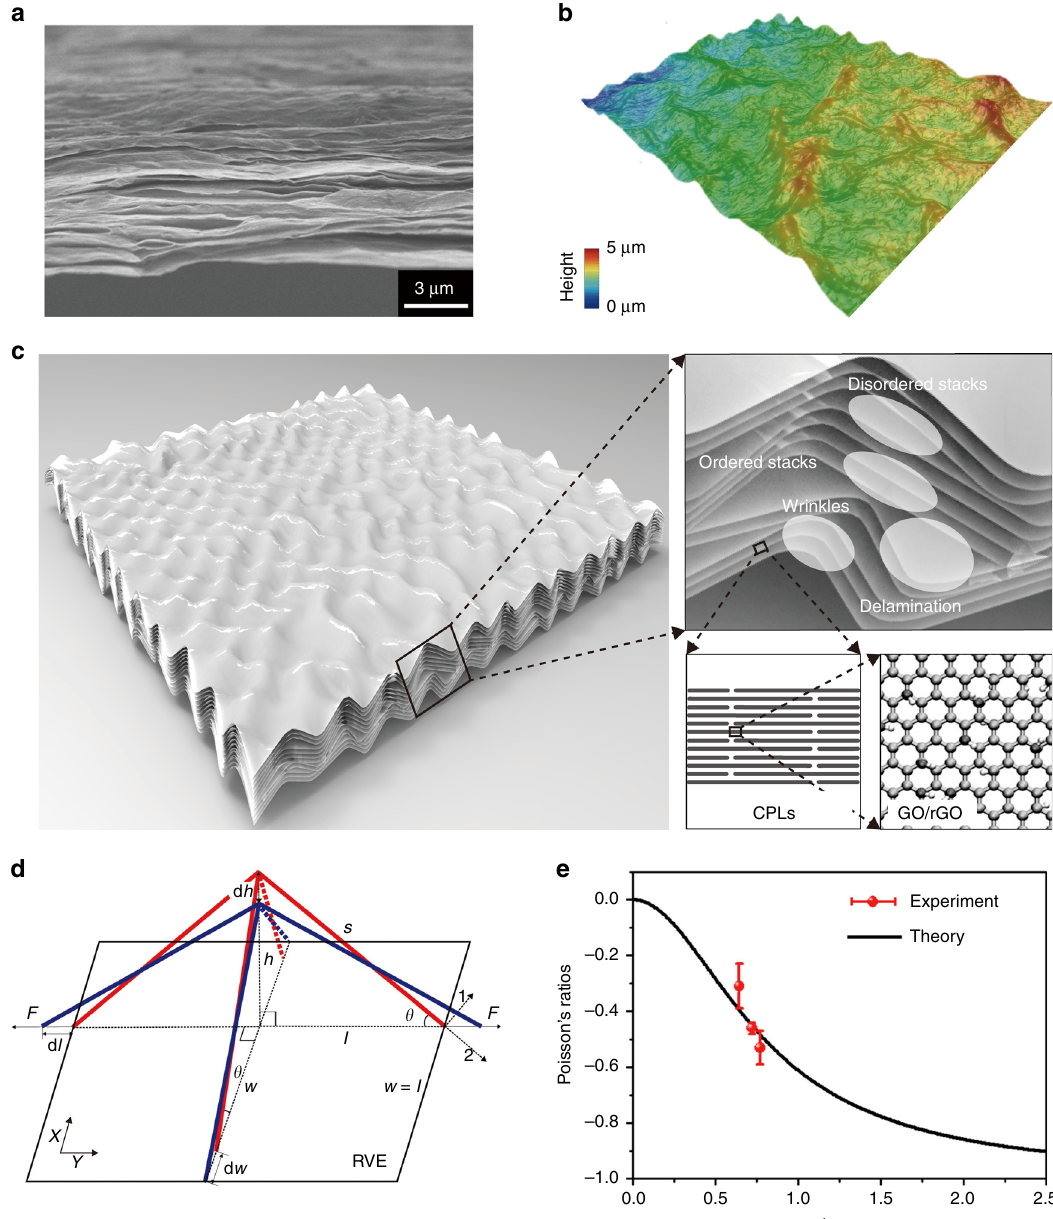
Fig. 4 Mechanisms of negative Poisson ratio (NPR) behaviors explained by the theoretical model. a Wrinkles, delamination of close-packed laminates (CPLs) and their ordered, disordered stacks in e -GO 0 fi lms characterized by scanning electron microscopy (SEM). b Three-dimensional reconstruction of the surface topography of e -GO 0 fi lms through optical microscopy. c Illustration of the multiscale hierarchical microstructure of a chemically modi fi ed graphene (CMG) fi lm featuring individual graphene sheets as the fundamental building blocks, CPLs and their inter-connected network. d A 4-stick representative volume element (RVE) model, where the red con fi guration is stretched by force F to the blue one. e Theoretical predictions and experimental measurements of the Poisson ’ s ratio as a function of the angle of alignment between CPLs, α , which is related to the value of θ in the model (see Supplementary Note 4 for details). The error bars for experimental data in panel ( e ) indicate the standard errors (three samples were measured). Source data are provided as a Source Data fi